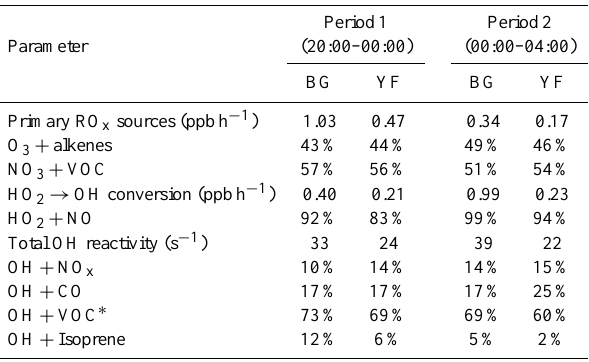
Table 4. Radical sources and sinks calculated by the base model for the time before (20:00–24:00CNST) and after (00:00–04:00CNST) midnight at the measurement sites in Backgarden (BG) and Yufa